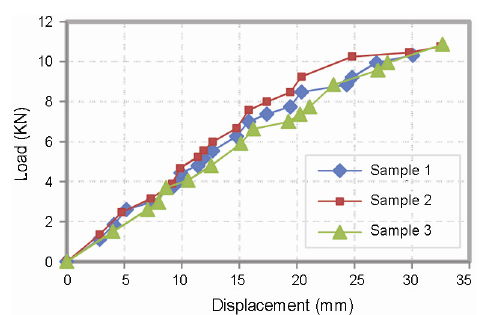
Fig. 15. Load-displacement curves for different specimens strengthened with two layers of GFRP and with surface prepara- tion